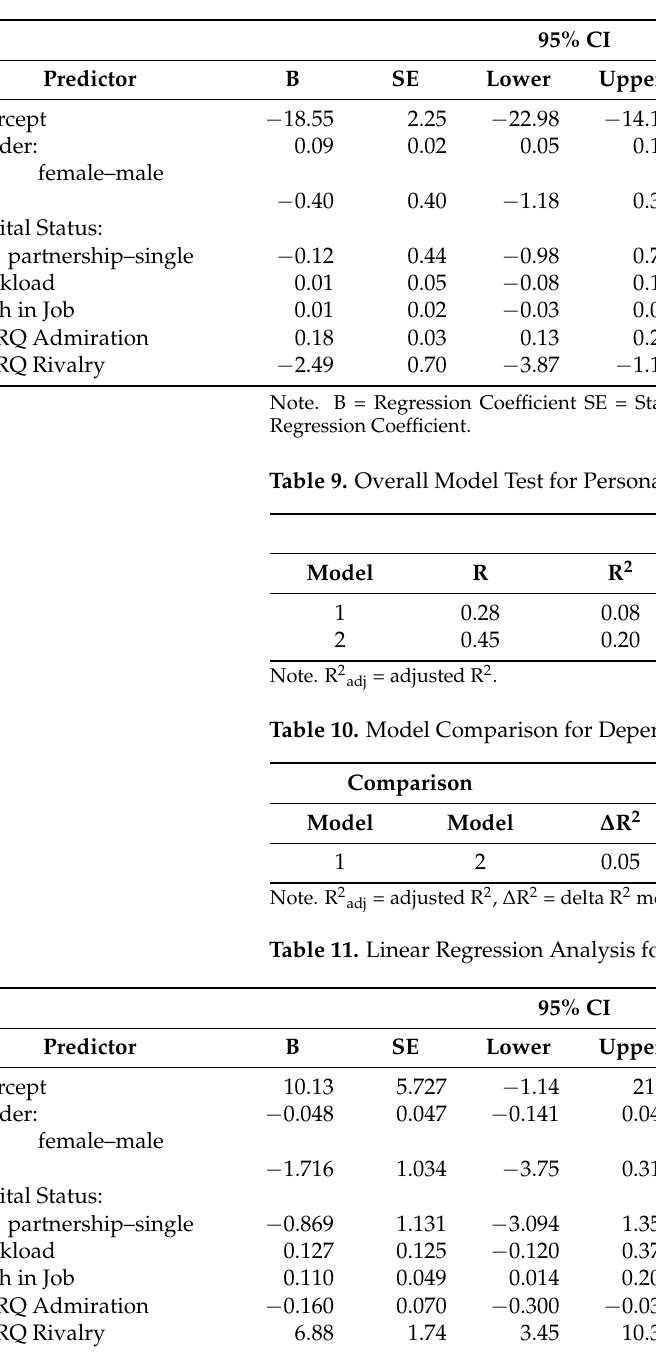
Table 8. Linear Regression Analysis for Personal Fullfillment.